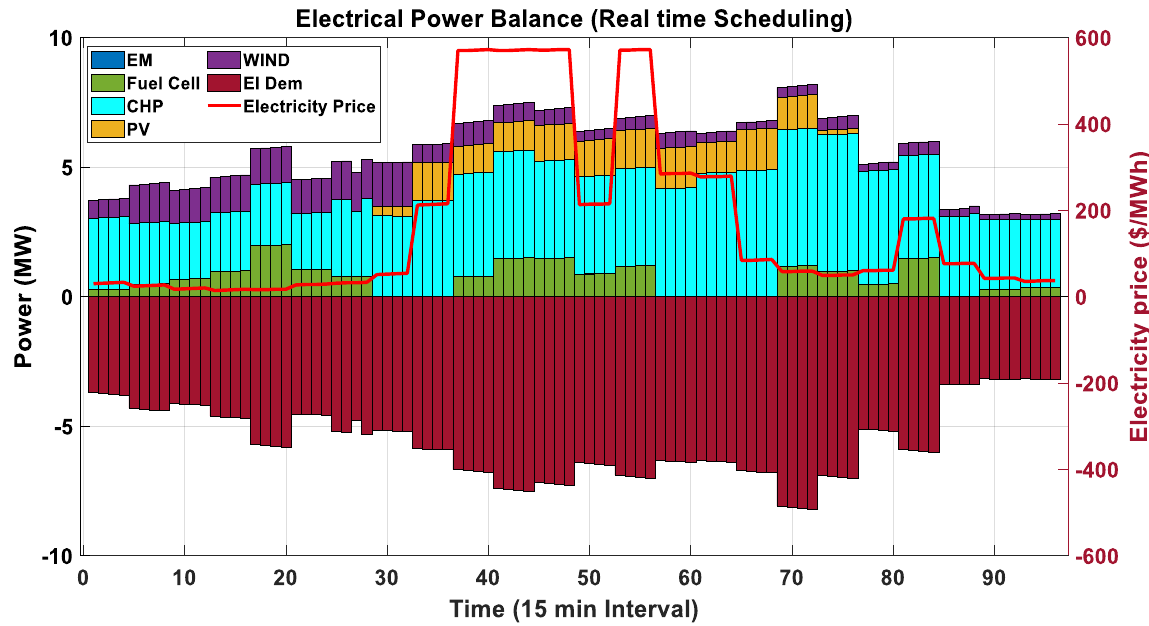
Figure 18. Case I power balance (electrical) in the VPP system for 15-min.